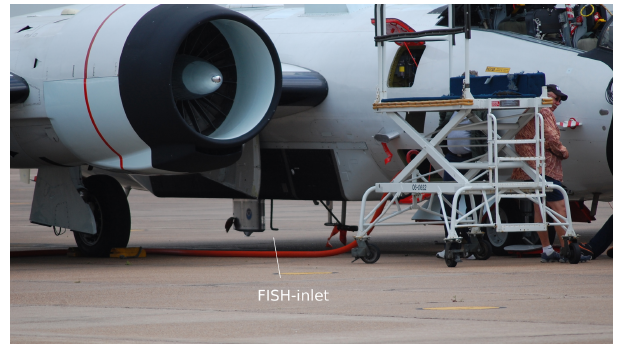
Figure 6. Bottom-mounted FISH inlet at WB-57 (photo: Armin Af- chine).